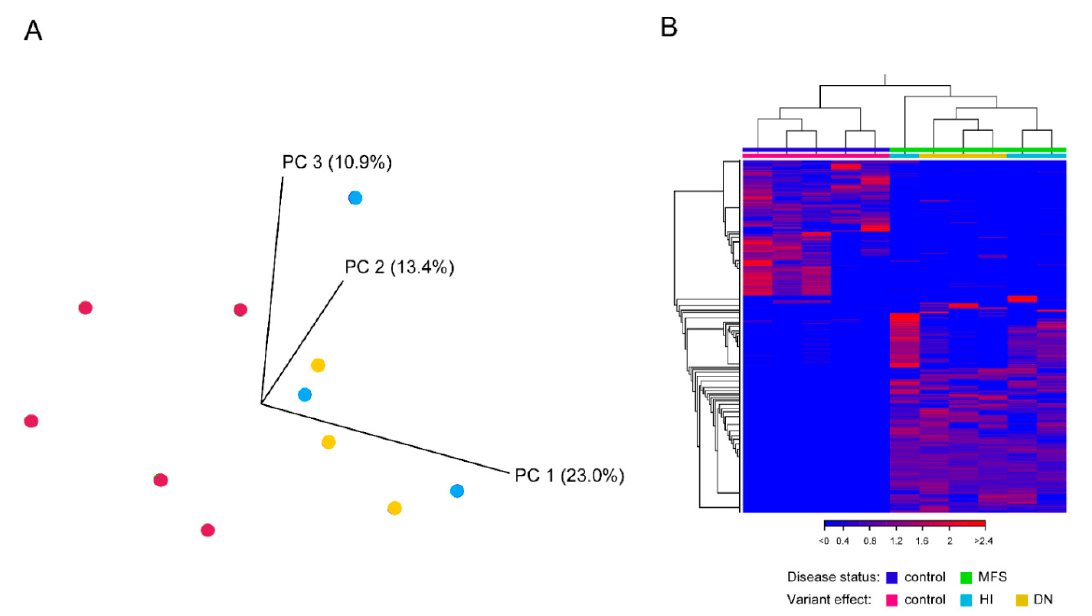
Figure 1. Visualization of gene expression data. ( A ) Three-dimensional scatter plots of principal component analysis on gene expression data. Cyan and yellow dots represent MFS samples with dominant negative (DN) and haploinsufficient (HI) FBN1 variants, respectively. Magenta dots represent controls. The numbers in brackets correspond to the proportion of variance explained by the respective principal component. ( B ) Heat map generated from gene expression data showing hierarchical clustering of MFS samples related to the predicted effect of the FBN1 variants.